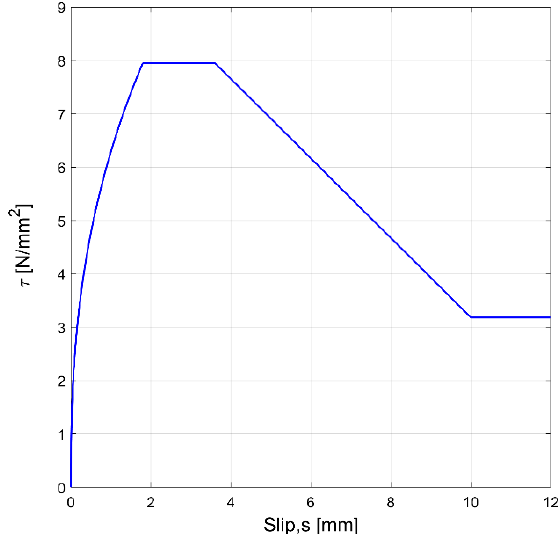
(cid:112) f cm = 7.95 N/mm 2 , τ bf = 0.4 τ b ,max ,